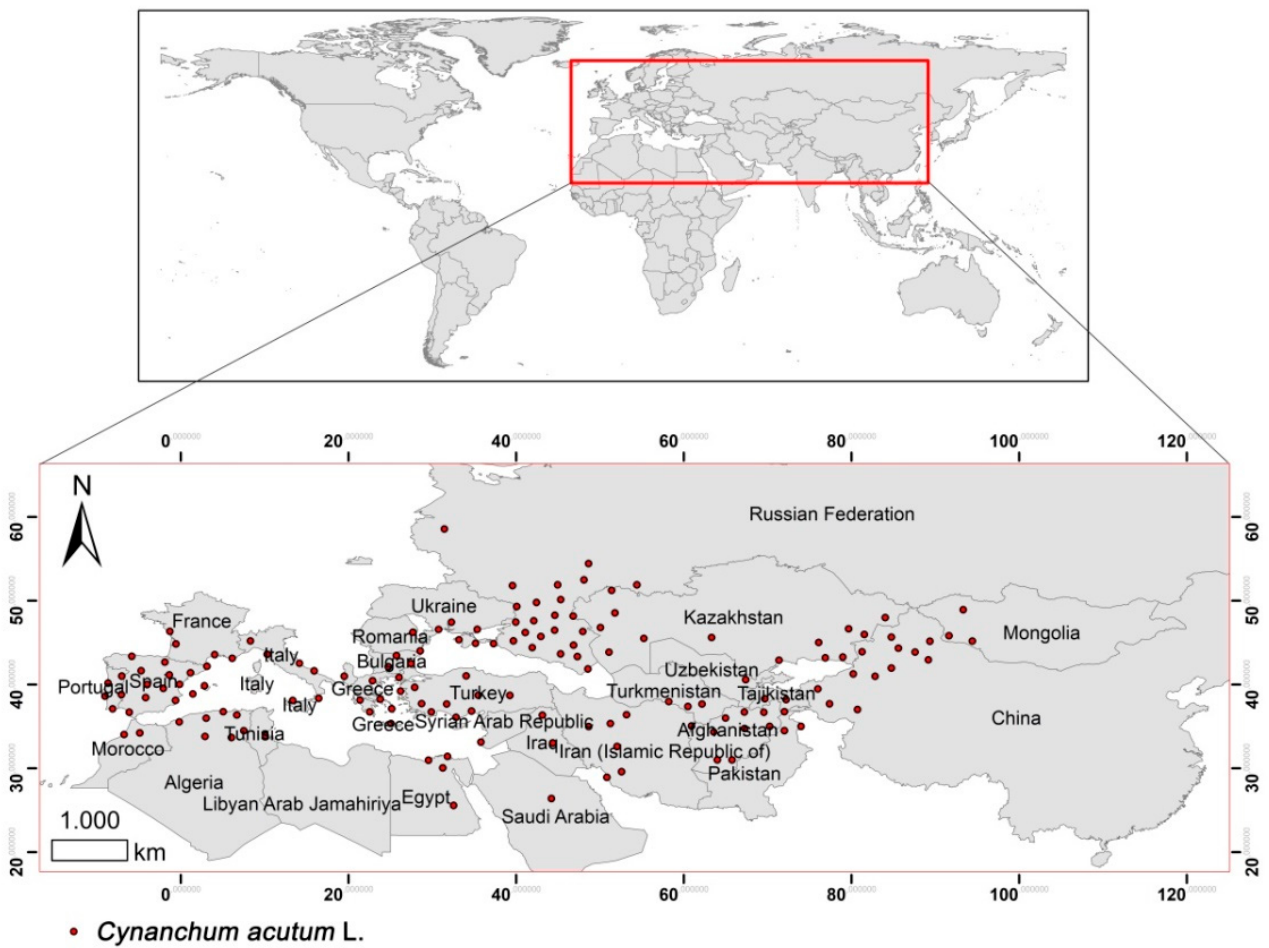
Figure 1. Geographic location of the study area and the distribution of occurrence data (spatially thinned).